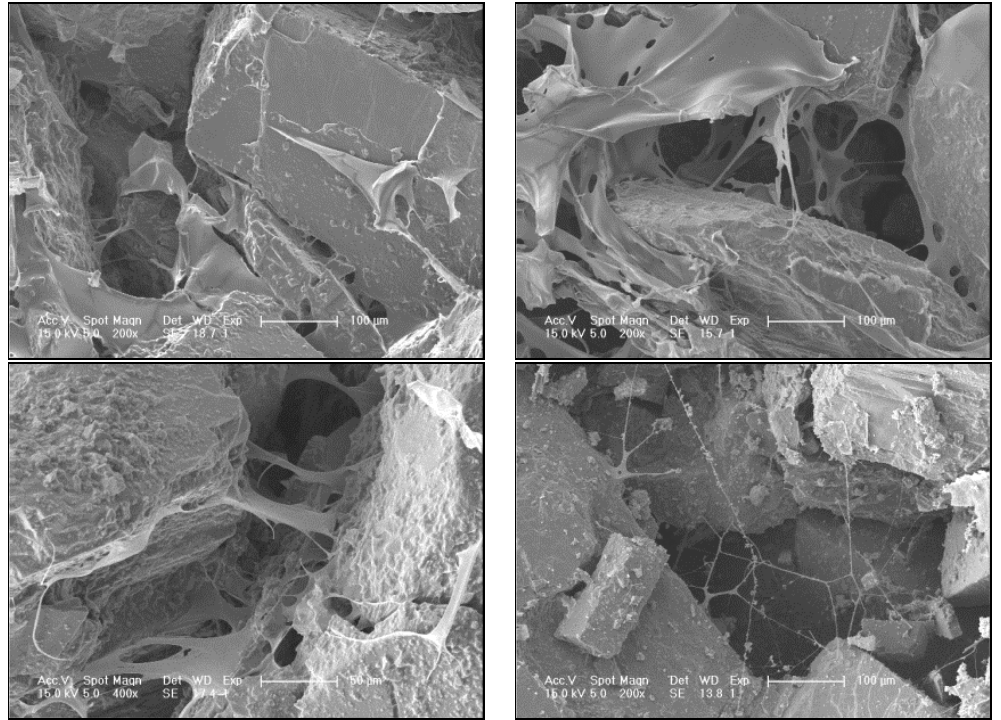
Figure 8. Morphological characteristics of gel of long core after waiting for solidification. Table 8. Final plugging rate of synergistic system under different overlying rock